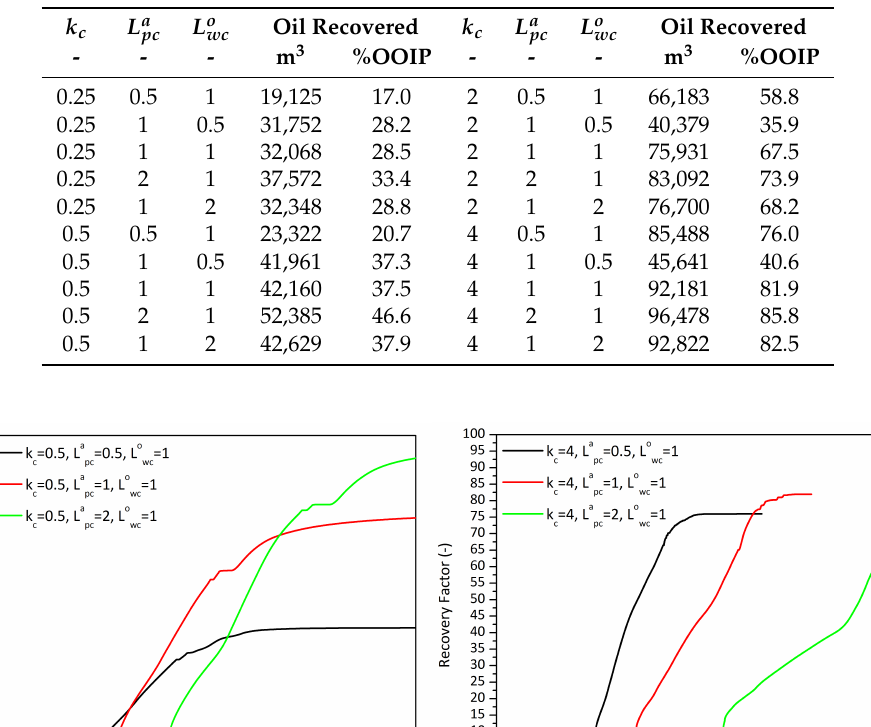
Table 4. Influence of the swelling and solubilization parameters on the oil recovery.